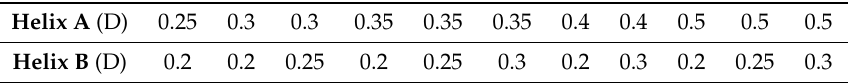
Table 2. Helical radii of the eleven combined helical geometries considered in this